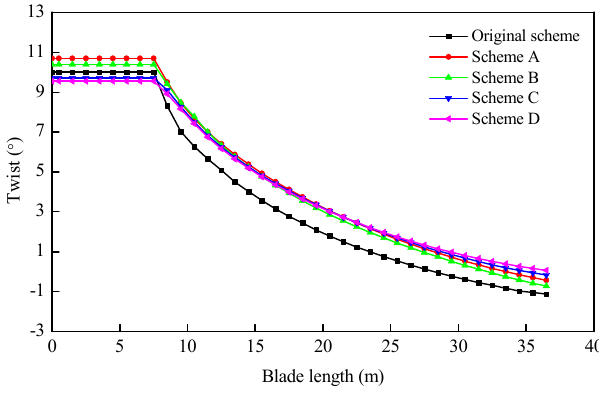
Figure 15. Comparison of twist distribution.